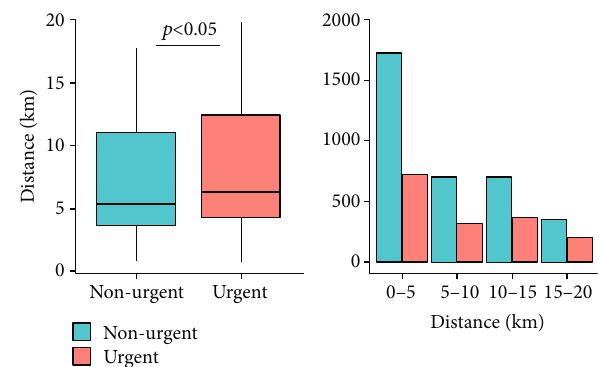
Figure 2: Linear distance to the pediatric ED for urgent and nonurgent visits in 2017.